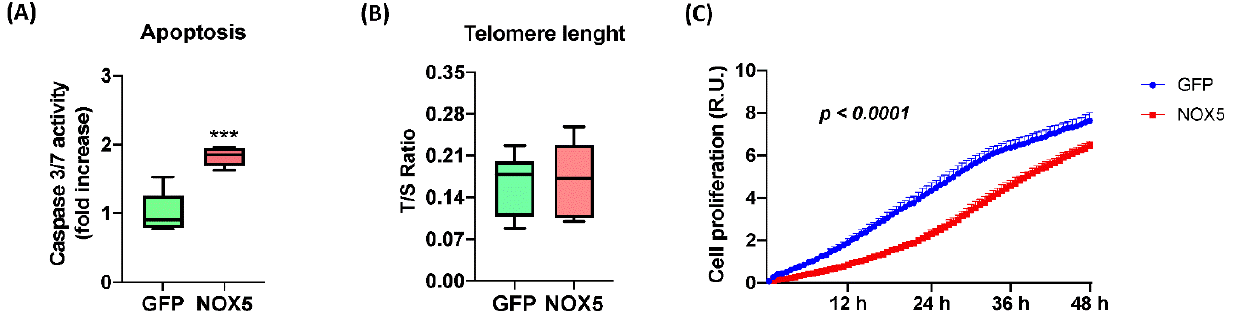
Figure 7. NOX5- β overexpression promotes apoptosis and inhibits cell proliferation in hCMEC/D3 cells. ( A ) Apoptosis measurement by Caspase 3/7 activity. ( n = 6) ( B ) Telomere length measurement as T/S ratio by qPCR. ( n = 6) ( C ) Cell proliferation measurement as impedance of E-plate by xCELLigence technology. ( n = 6–8) GFP: GFP-infected hCMEC/D3 cells; NOX5: NOX5- β -infected hCMEC/D3 cells. *** p < 0.001 vs. GFP-infected cells. Data presented as mean ± SEM. R.U.: relative units. T/S ratio: ratio between telomeres repetitions and single copy gene.